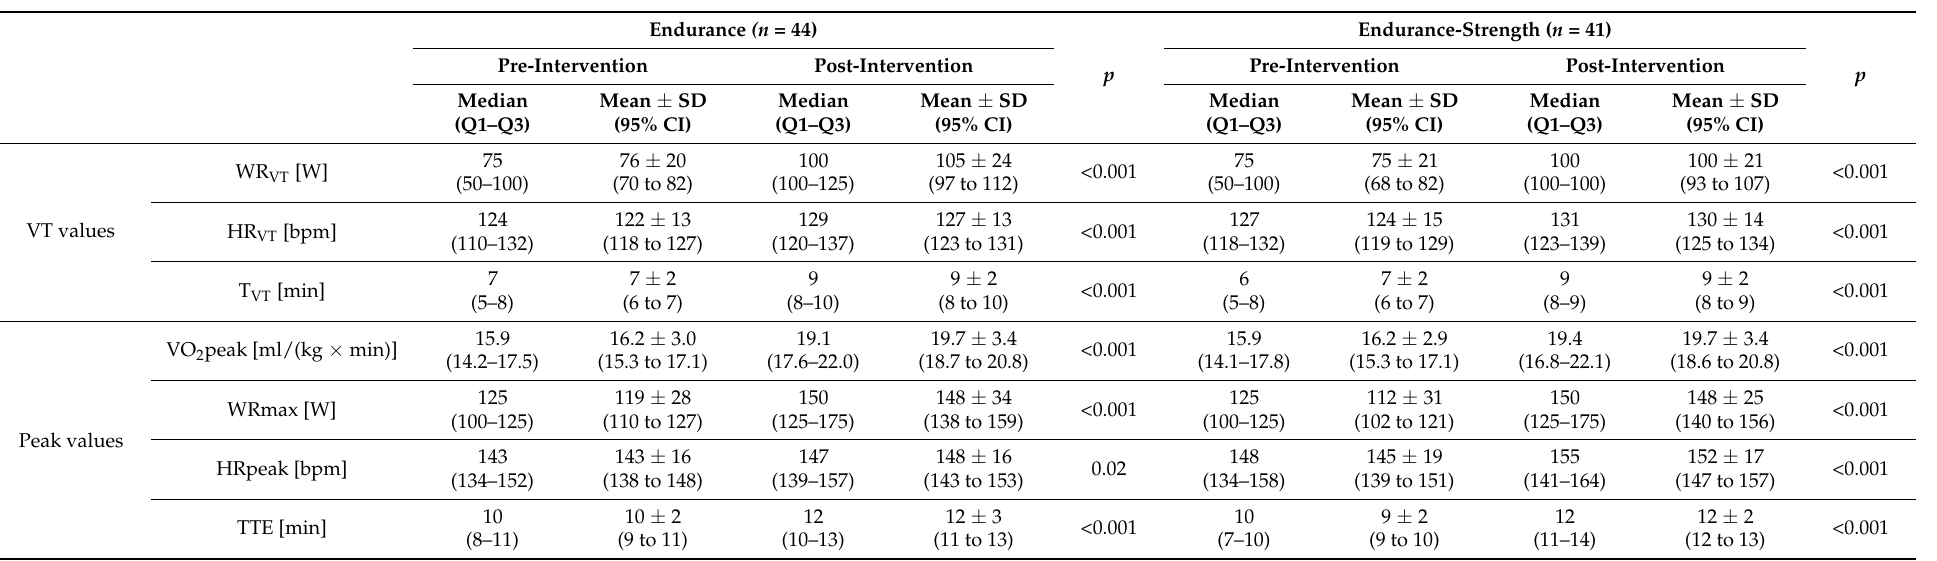
Table 4. The effect of endurance ( n = 44) and endurance-strength training ( n = 41) on physical